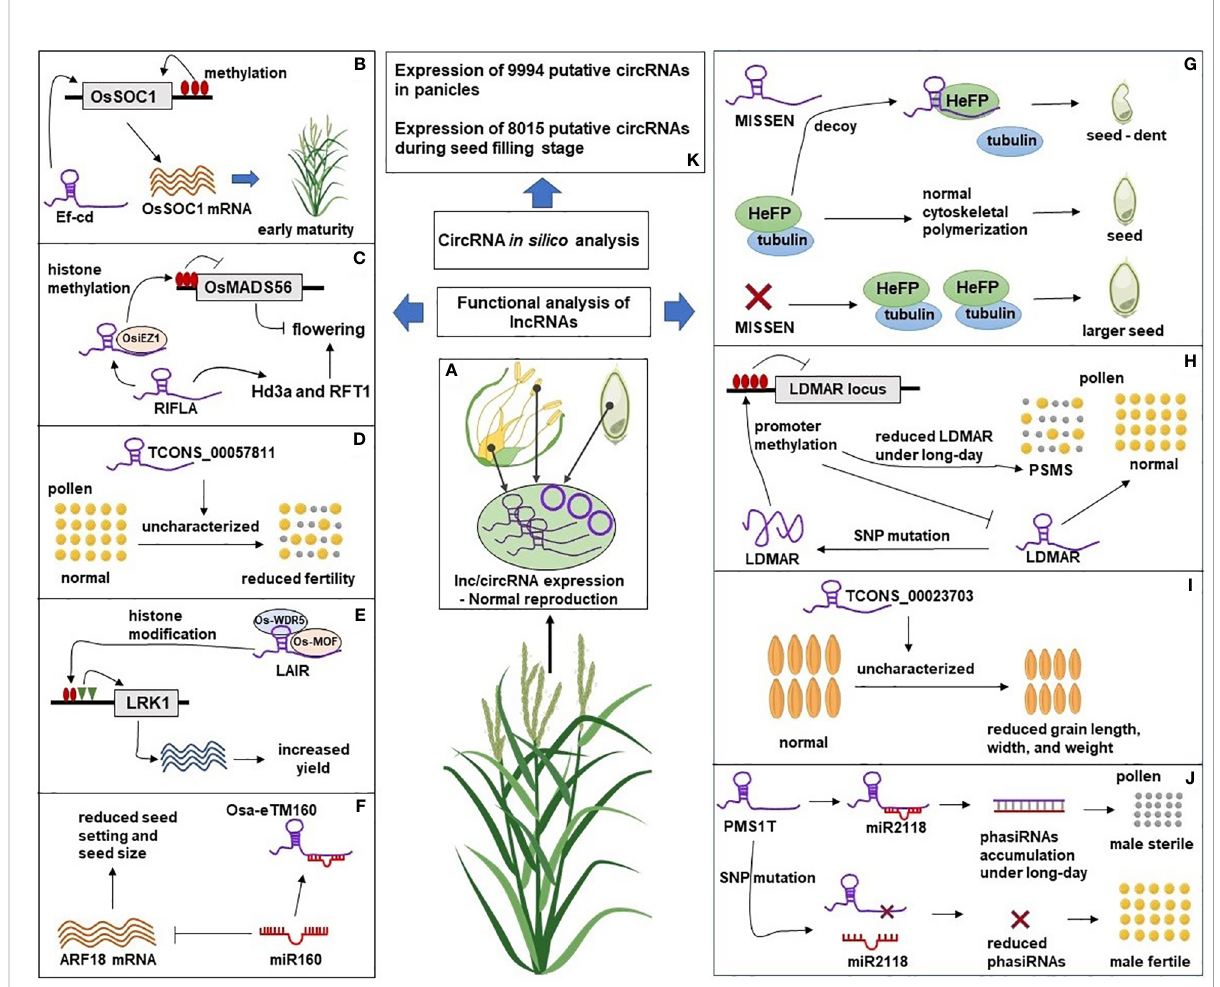
FIGURE 2 A Schematic representation of lncRNAs and circRNAs roles in rice reproduction. (A) The natural expression of lncRNAs and circRNAs in reproductive tissues leads to normal rice reproductive development. (B) LncRNA Ef-cd could promote the expression of fl owering gene OsSOC1 leading to early fl owering. (C) Overexpression of lncRNA RIFLA induced the expression of fl owering genes Hd3a and RFT1 and inhibited the expression of fl oral repressor gene OsMADS56 by recruiting histone methyltransferase OsiEZ1 at OsMADS56 locus. (D) Overexpression of lncRNA TCONS_00057811 caused reduced pollen fertility and seed set in the transgenic plant through an uncharacterized mechanism. (E) Overexpression of lncRNA LAIR promoted H3K4me3 and H4K16ac at LRK1 locus by recruiting histone modifying proteins (OsMOF and OsWDR5) resulting in increased expression of LRK, a gene family related to rice yield. (F) Overexpression of lncRNA Osa-eTM sponged miR160 and reduced its negative effect on ARF18 mRNA leading to reduced seed setting and seed size in transgenic lines. (G) HeFP, a helicase family protein, interacts with tubulin to regulate cytoskeletal polymerization during endosperm development. LncRNA MISSEN regulates HeFP ensuring normal endosperm development. Overexpression of MISSEN could interrupt the HeFP-tubulin interaction resulting in dents and bulges in developing seeds. Down-regulation of MISSEN removed the activity of MISSEN on HeFP, resulting in the production of larger seeds. (H) Expression of lncRNA LDMAR is required for pollen development. Change in the secondary structure of LDMAR caused by SNP mutation increased methylation at the LDMAR locus and reduced LDMAR expression speci fi city under long-day photoperiod and PSMS. (I) Down- regulation of lncRNA TCONS_00023703 resulted in reduced grain length, width, and 1000-grain weight through an unknown mechanism. (J) LncRNA PMS1T is the precursor of 21nt-phasiRNAs, which are involved in photoperiod-sensitive male sterility (PSMS) under the long-day condition. Down-regulation of phasiRNAs through SNP mutation near their binding site on PMS1T resulted in male fertility. (K) In silico analysis identi fi ed the expression of circRNAs in rice reproductive tissues. Functional experiments are needed to reveal the mechanistic roles of circRNAs during rice reproductive development. The Rice plant was “ Created with BioRender.com ”